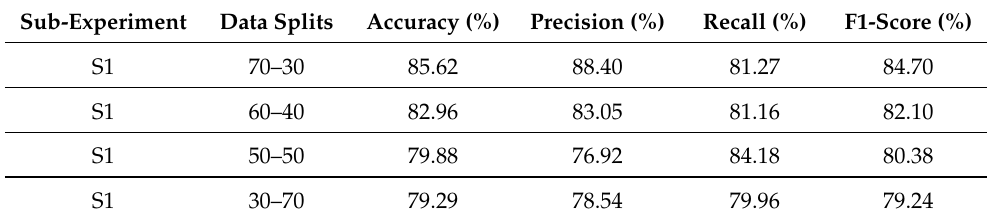
Table 5. USE-based proposed deep neural network.